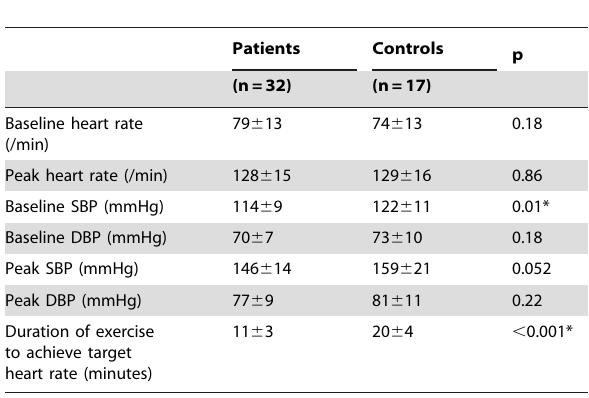
*Statistically significant. Abbreviations as in table